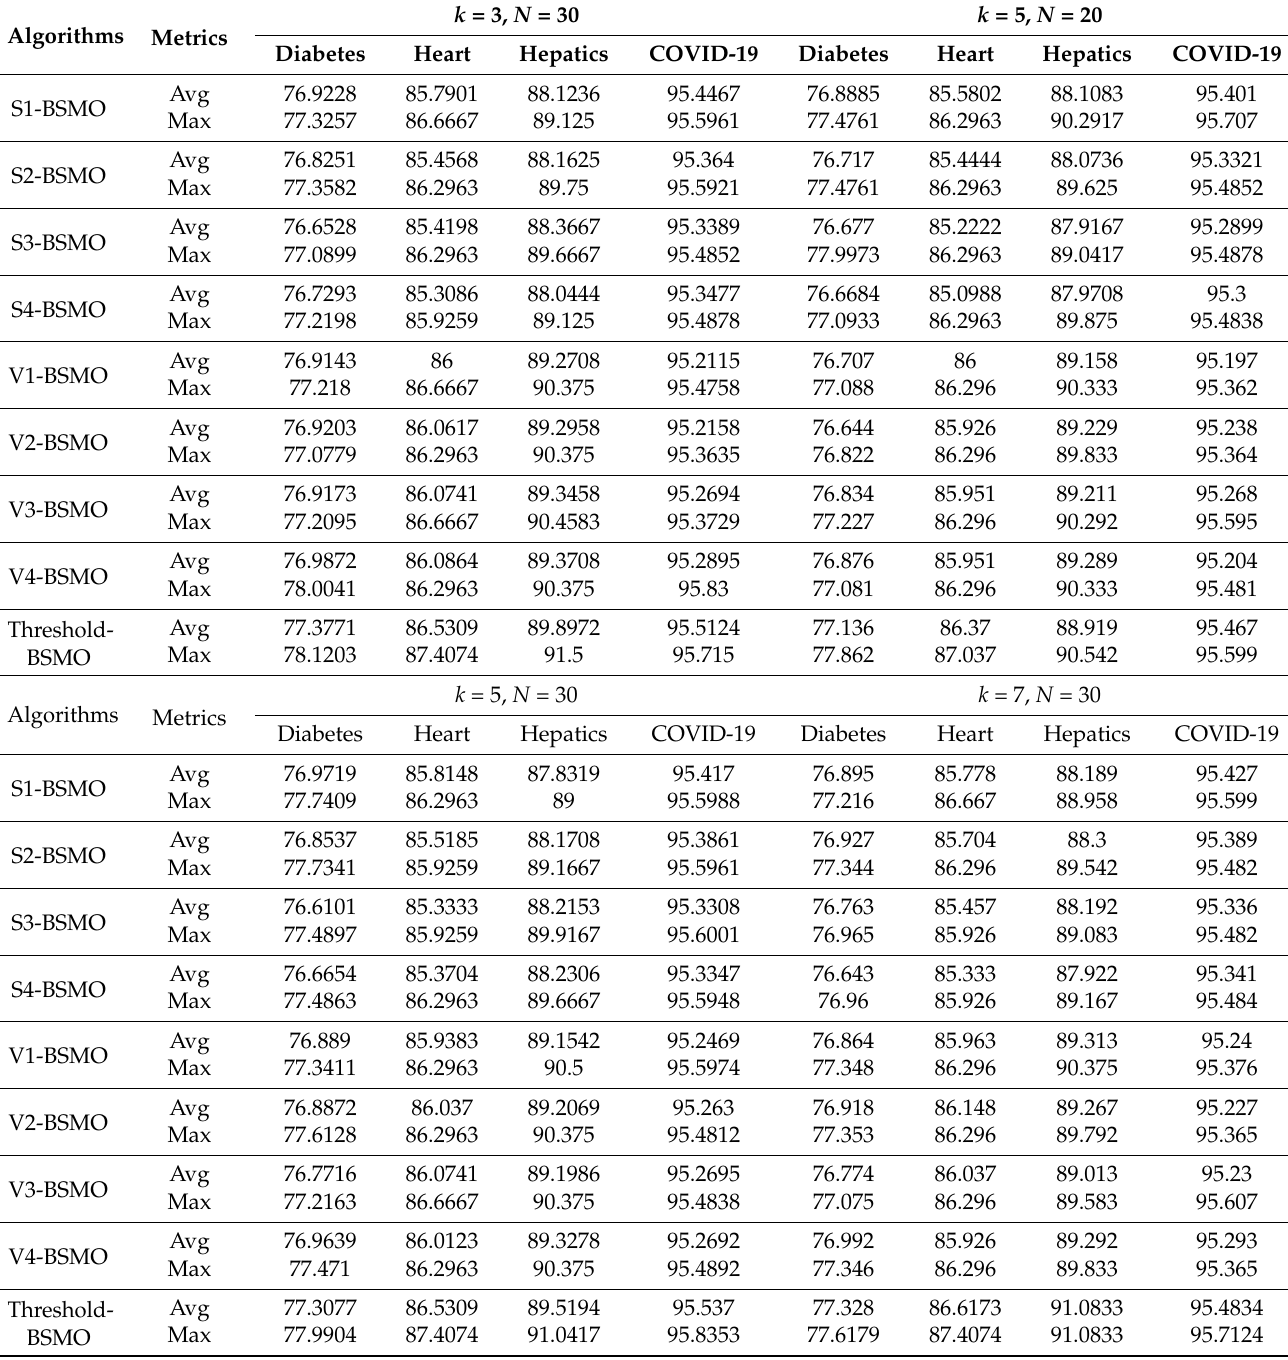
Table A3. Parameters setting of BSMO algorithm in terms of accuracy